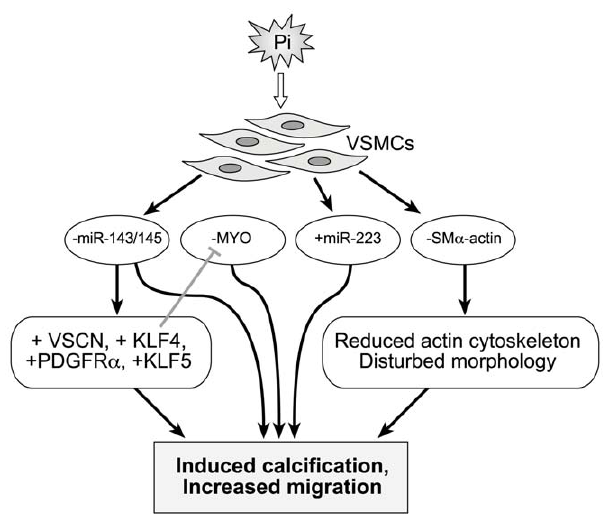
Figure 7. Schematic representation of the hypothetical molec- ular and cellular consequences of elevated phosphate expo- sure in VSMCs. Elevated extracellular Pi resulted in the downregu- lation of VSMC master regulators, MYO and SM a A. The expression of miR-143 and miR-145 was also downregulated in Pi-treated cells. These events affected downstream processes by reducing the size of the actin cytoskeleton, disturbing cell morphology, upregulating miR-143 and miR-145 targets and, ultimately, leading to increased calcification and a greater VSMC migration rate. Up-regulation of miR-223 further enhances VSMC migration and reduces the amount of actin cytoskel- eton. ‘-’ indicates downregulation, whereas ‘ + ’ indicates upregulation of the respective miRNAs or genes. See Fig. 2 for